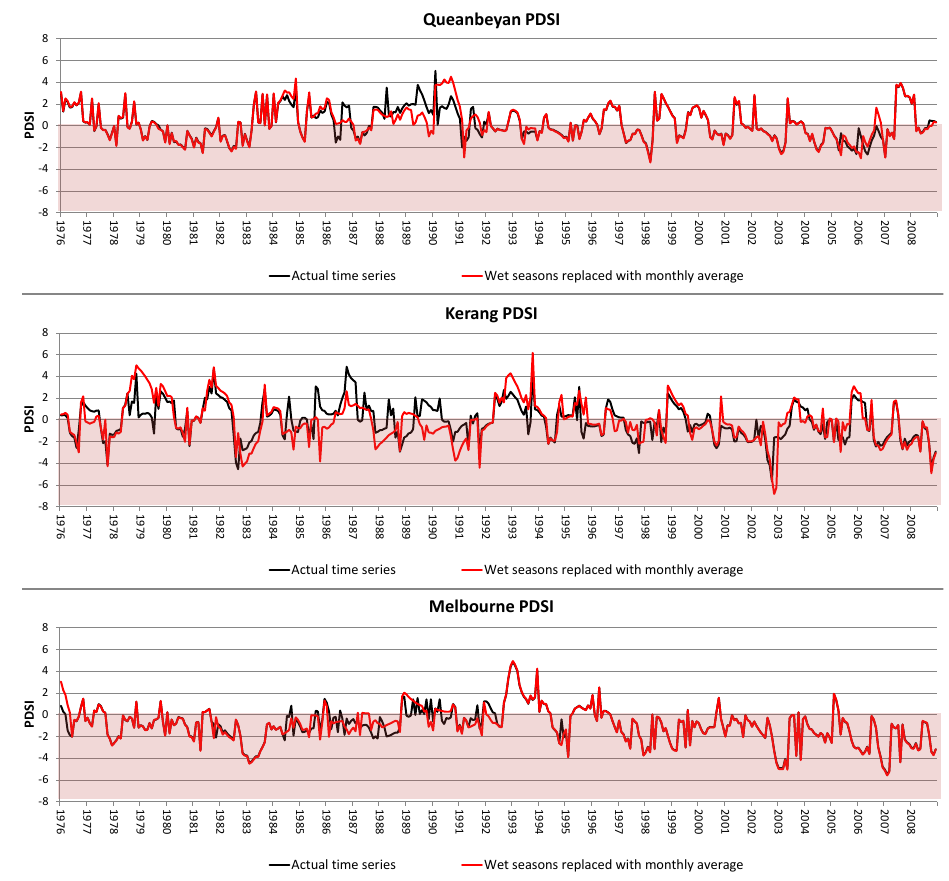
Figure 17. Monthly time series of PDSI from 1976 to 2009 at Queanbeyan, Kerang and Melbourne (red shading shows PDSI values that indicate dry